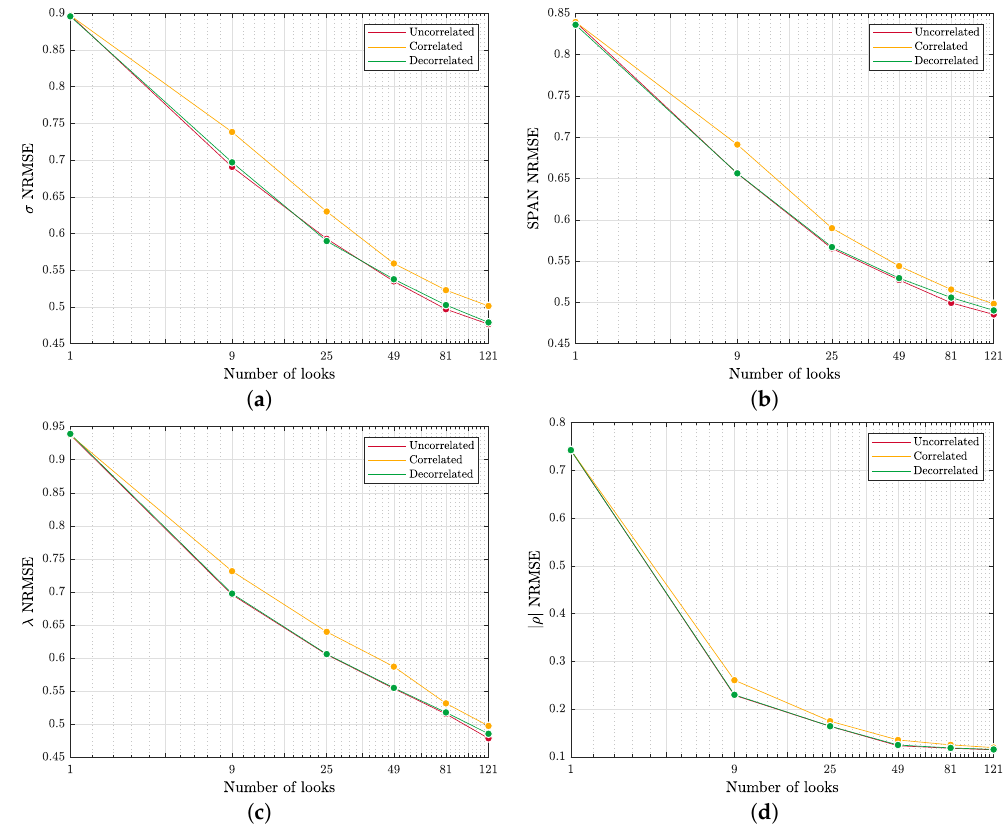
Figure 5. Normalized root mean square error (NRMSE) versus number of looks (size of box filter) for ( a ) intensity; ( b ) SPAN; ( c ) eigenvalue; ( d ) coherence.